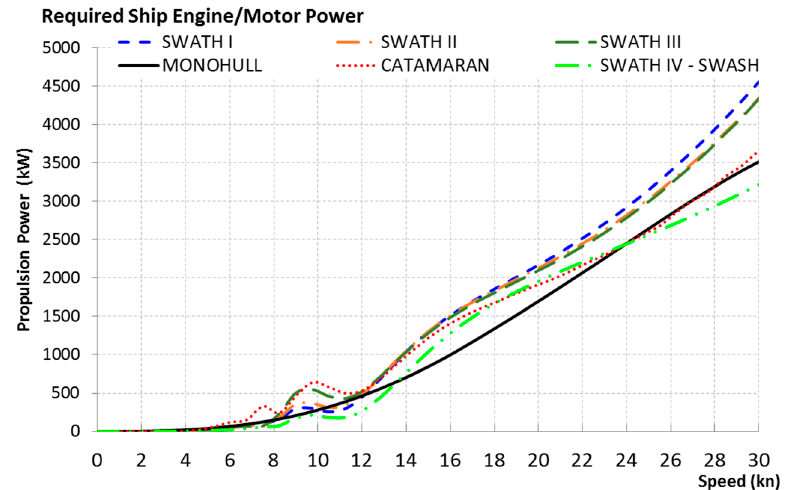
Figure 7. Approximate plot of the relationship of required drive power versus longitudinal speed for MONOHULL, CATAMARAN, SWATH I, SWATH II, SWATH III, SWATH IV–SWASH vessels.